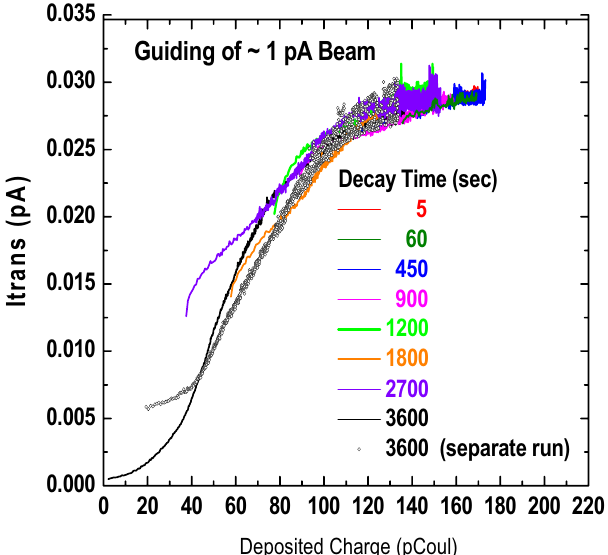
Figure 6. Transmitted beam intensity as a function of deposited charge determined as described in the